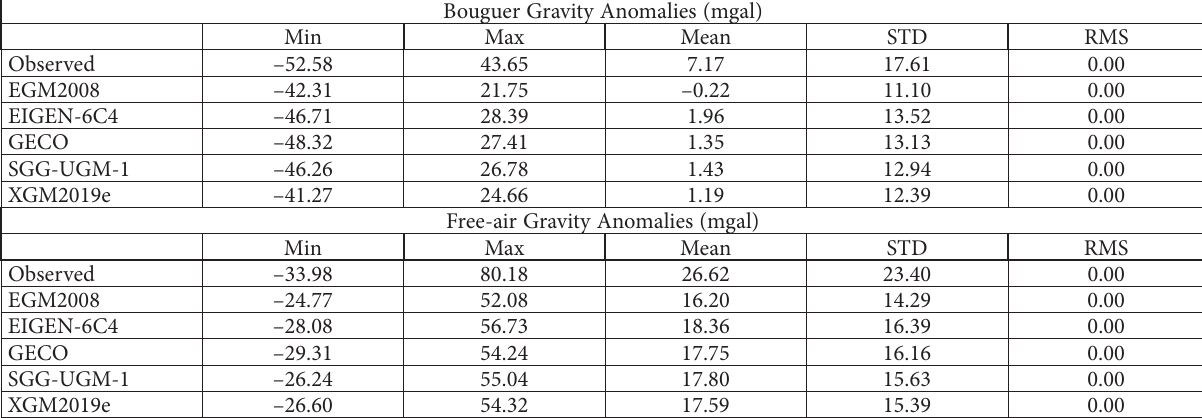
Table 2. Statistics of the ground-based and GGM-derived Bouguer and free-air gravity anomalies Bouguer Gravity Anomalies